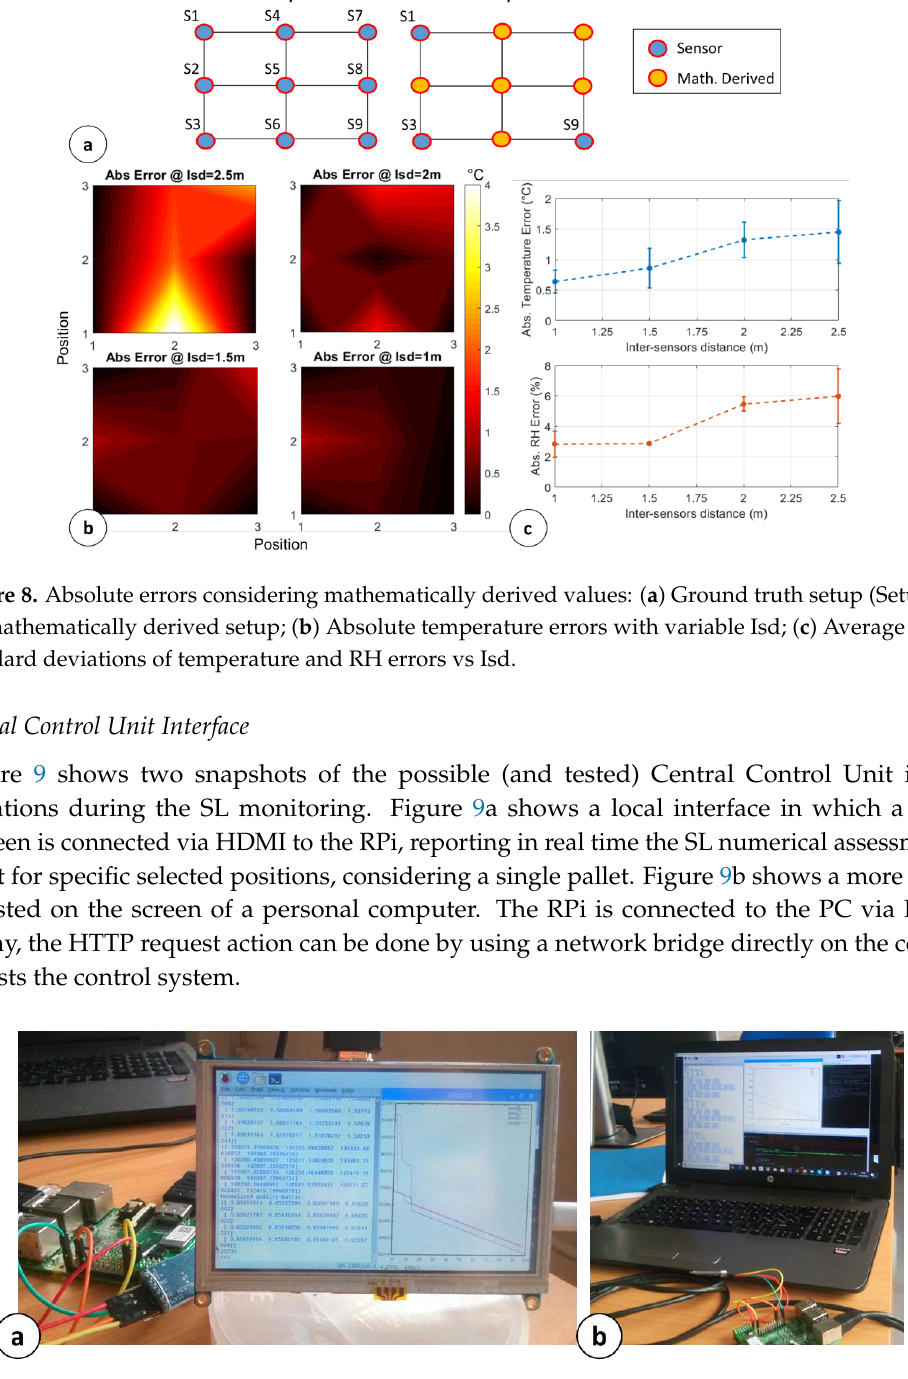
Figure 9. Snapshots of Central Control Unit possible setups: ( a ) Local Interface through 7″ LCD; ( b ) Dedicated interface on a personal computer through Ethernet connection.